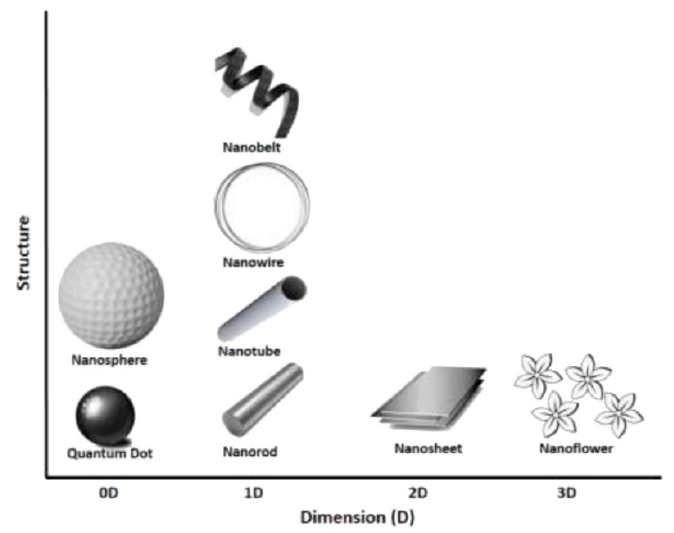
Figure 3. Graphical illustration of structural dimensionality of nanomaterials. Reproduced with permission from Elsevier [18].